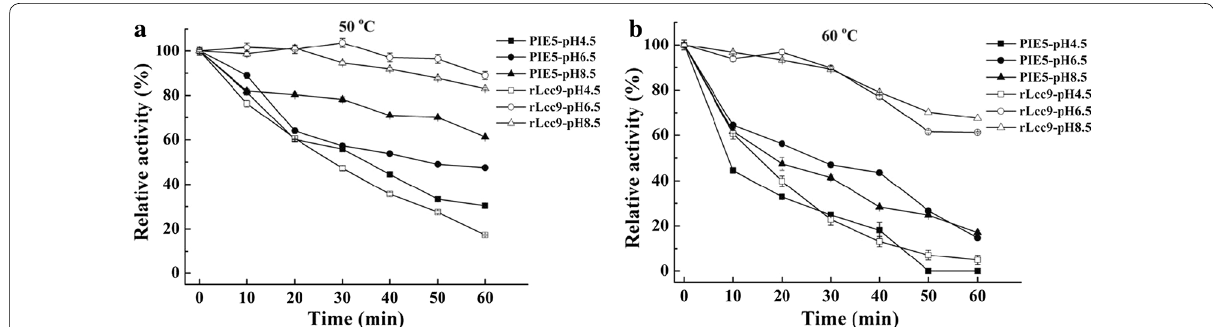
Fig. 2 pH stabilities and thermostabilities of rLcc9 and PIE5 as determined at incubation temperatures of 50 °C ( a ) and 60 °C ( b ), respectively. The data presented are the average values from triplicate parallel experiments and technical repeats of measurements (n